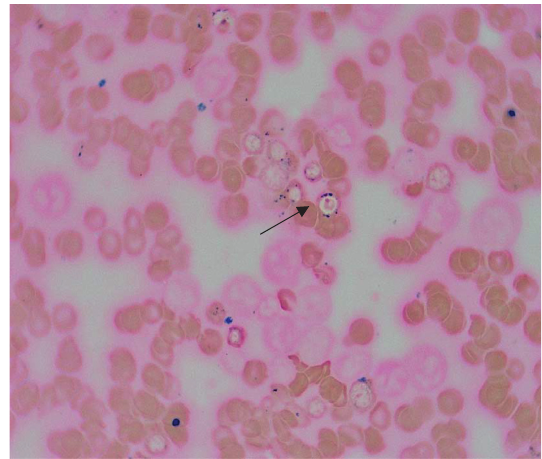
Figure 1: Bone marrow smear showing that about 10% of erythroid precursors are ring sideroblasts (arrow) (Perl’s Prussian blue stain, ×